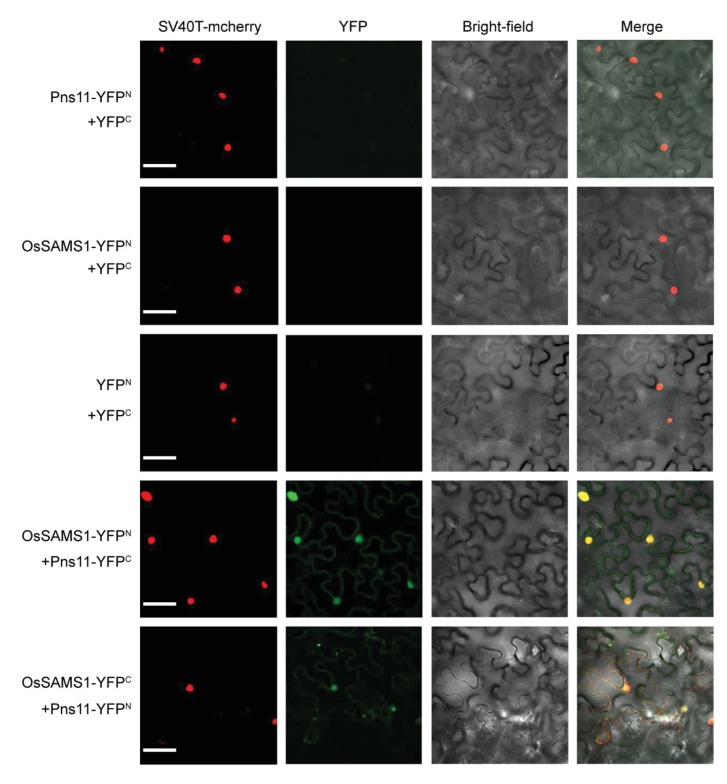
Pns11 and OsSAMS1 are co-localized in both nucleus and cytoplasm.Bimolecular fluorescence complementation (BiFC) interaction. Constructs expressing Pns11 and OsSAMS1 fused to the N- or C-terminal portions of yellow fluorescent protein (YFP) were delivered to N. benthamiana leaf cells by agroinfiltration. Cells were photographed 3 days post-infiltration at 40X magnification using a confocal laser scanning microscope. SV40T-mCherry was used as a marker for the nucleus. The co-expressed proteins are indicated above the photographs, which are representative of results with all possible combinations of fusion proteins. Bar = 20 μm.